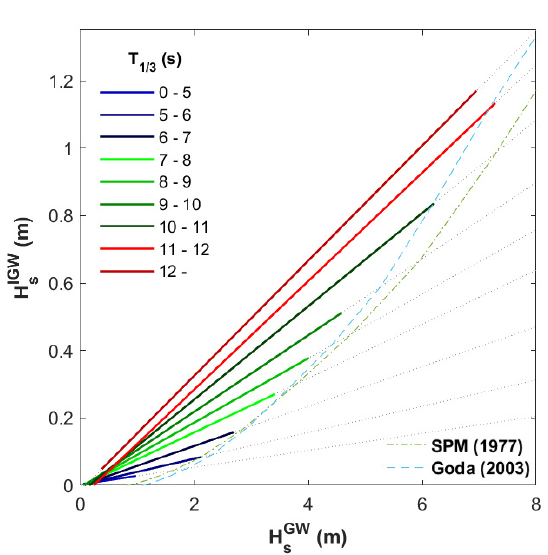
Figure 10. Collection of the regression lines from Figure 8 and comparison with the formulae of the Shore Protection Manual (SPM) [25] and Goda [32].